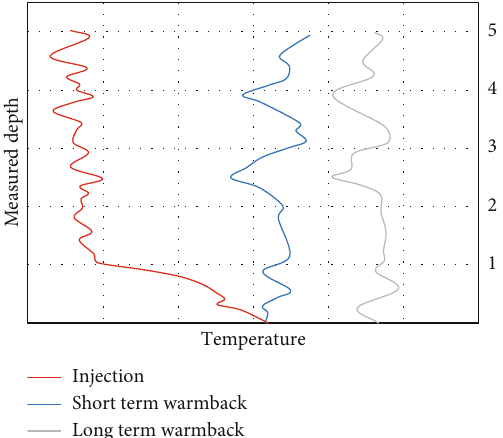
Figure 3: DTS measured temperature pro fi le during injection and shut-in, indicating the fl ow distribution across the stage modi fi ed after